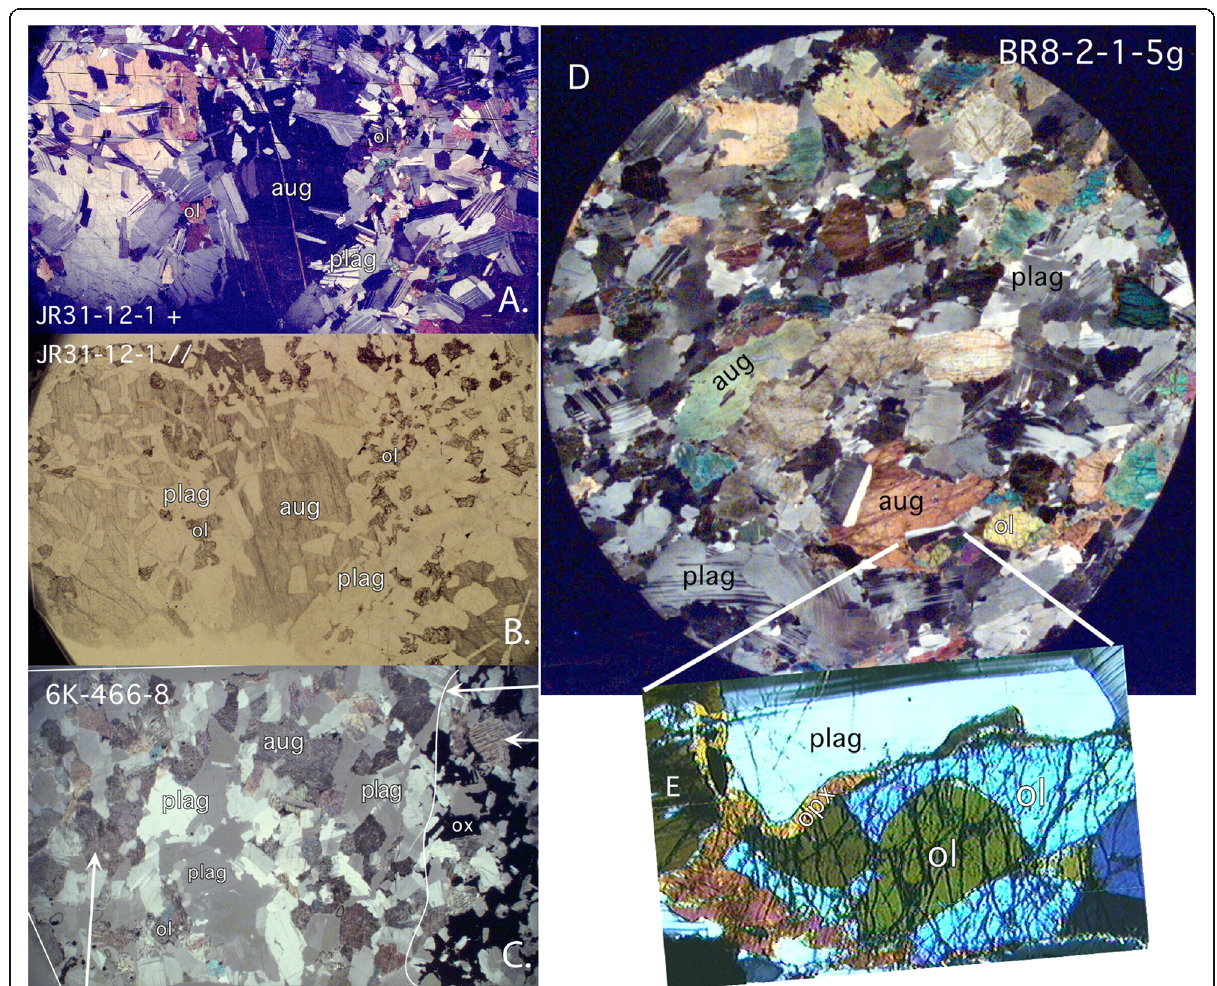
Fig. 8 Photomicrographs of various Atlantis Bank gabbros. a Sample # JR31-12-1: Sub-ophitic augite surrounds plagioclase laths with interstitial olivine (in crossed polars). Plagioclase, plagioclase; aug, augite; ol, olivine. Field of view is 7.5 cm across. b Same slide in plane polarized light. c Sample 6K-466-8: Field of view is 2.5 cm across. The white line indicates the contact between olivine gabbronorite and oxide gabbronorite. The picture uses a combination of reflected and plain polarized light illumination to distinguish different minerals. White arrows point to the analyzed areas. d Sample BR8-2-1-5g: This sample underwent weak, high-temperature, crystal-plastic deformation, as indicated by kink-banded pyroxene and bent plagioclase crystals. Image in cross-polarized light with a field of view 2.5 cm across. e Detail of d showing an interstitial thin orthopyroxene grain between interlocking olivine and